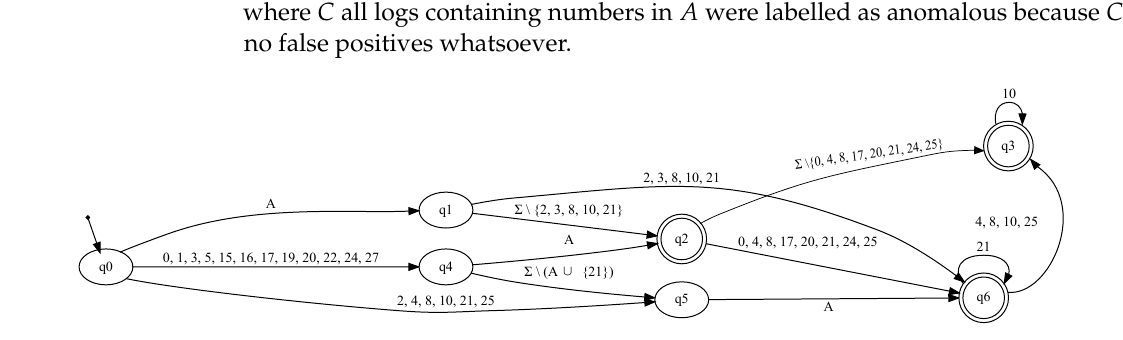
DNA promoter sequences are in charge of controlling gene activation or repression.